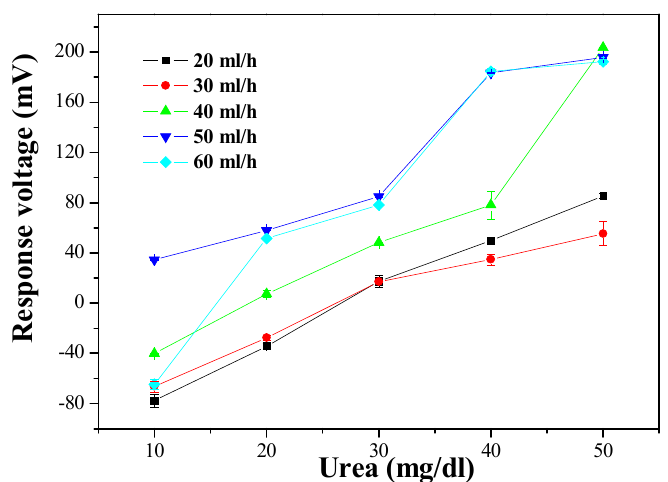
Figure 8. The responses of the urea biosensor based on MBs-urease / GO / NiO by integrating the microfluidic measurement system.